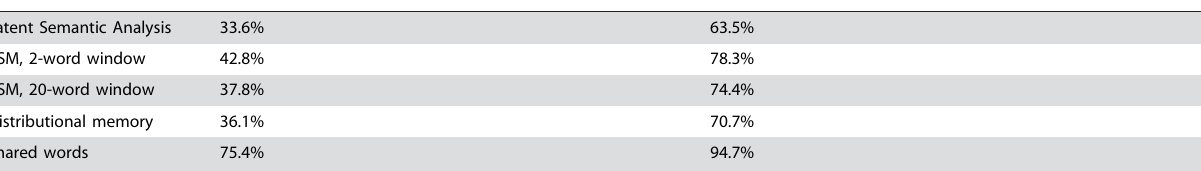
Text similarity algorithm Lab-sourced responses correctly classified ( N =2,400) Crowdsourced responses correctly classified ( N =4,000)